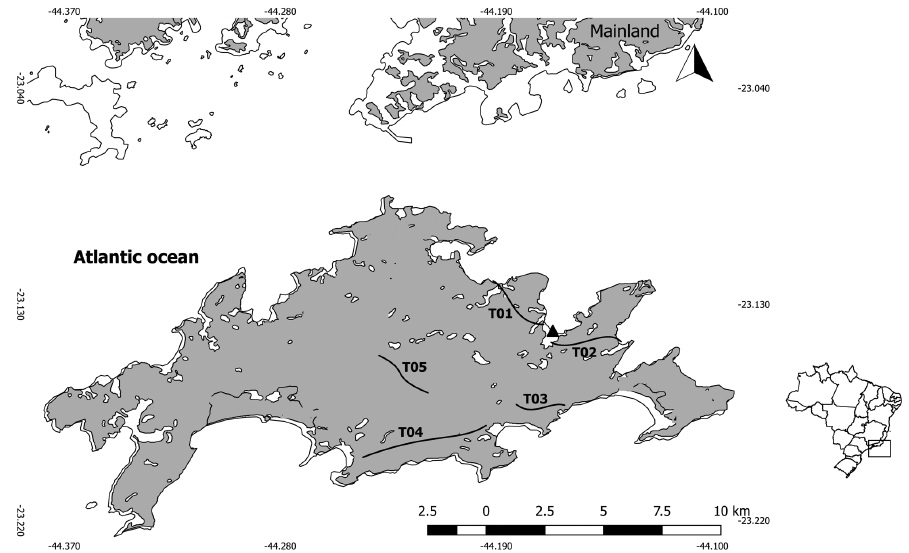
Figure 1. Ilha Grande in the state of Rio de Janeiro, Brazil and location of the transects. Black triangle representing the Abraão village. Table 1. Characteristics of transects (length, altitude and region), number of times each transect was walked (N samples), total kilometers walked, and the encounter rates of Cuniculus paca per